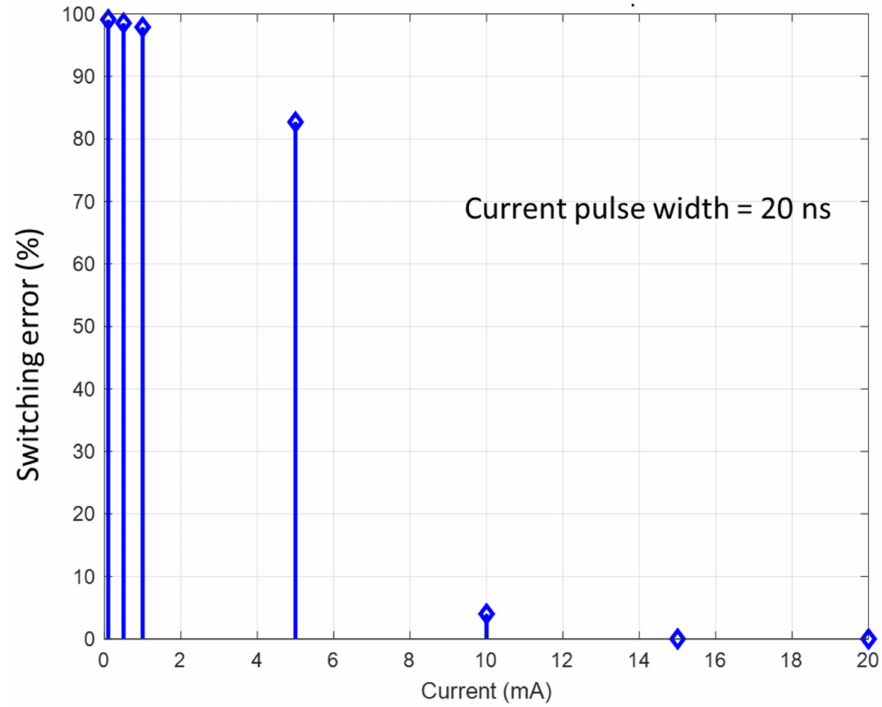
Figure 3. Switching error probability as a function of injected current magnitude. The energy dissipated is proportional to the square of the current. The current was kept on for the entire duration of the simulation, which was 20 ns.